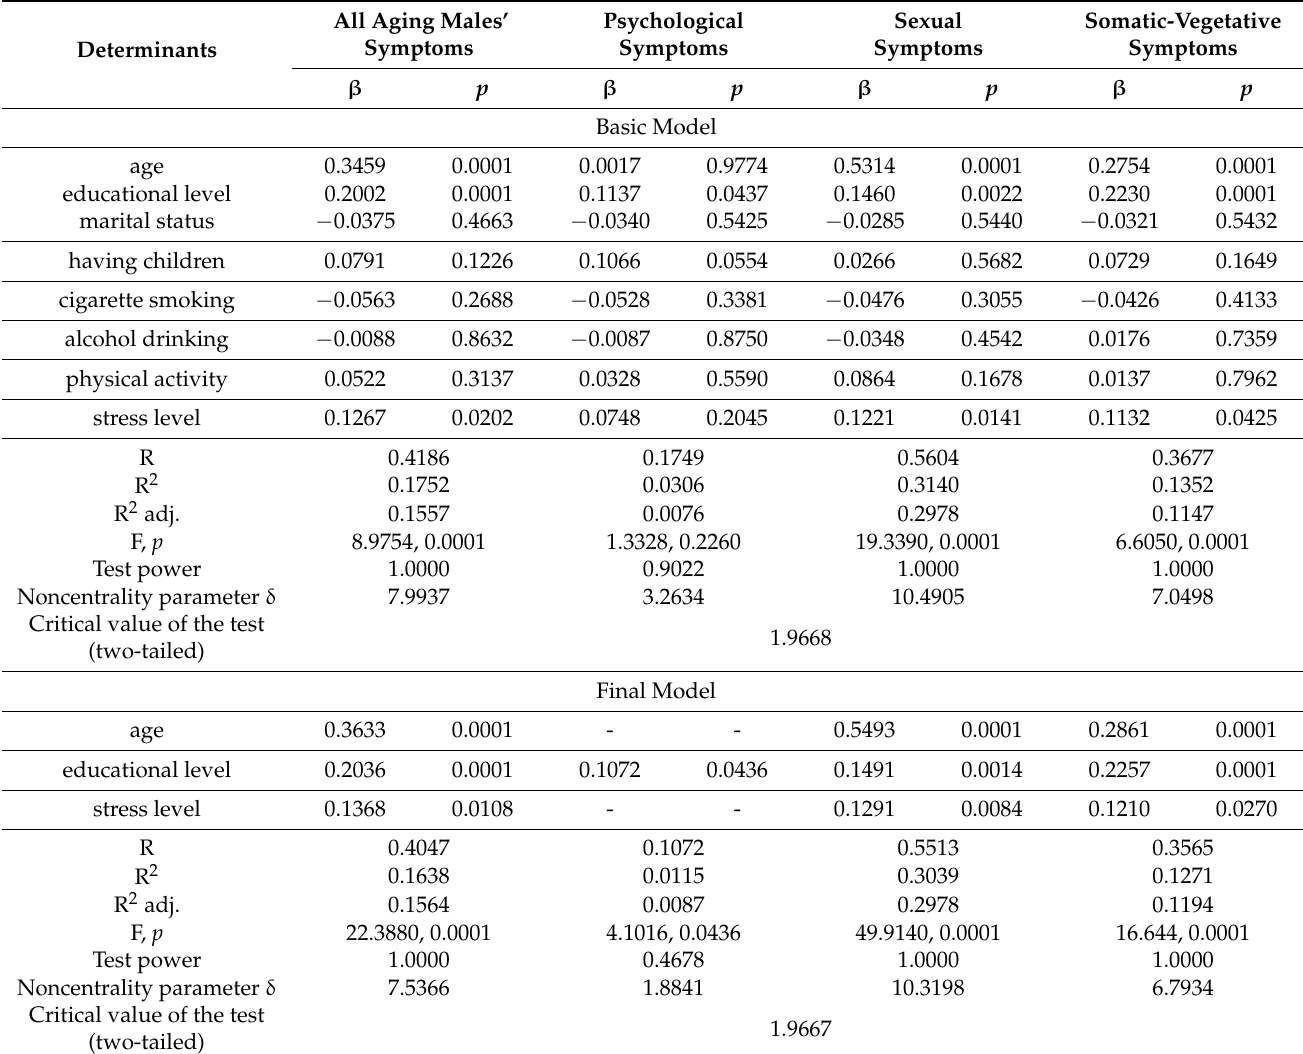
Table 2. Results of backward stepwise regression (basic and final